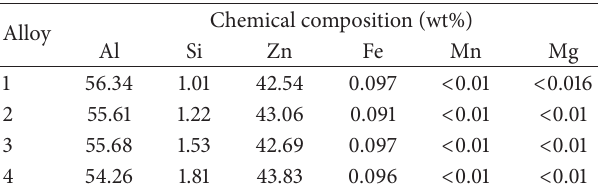
Table 1: Chemical composition of the Al-Zn-Si alloys used in the present